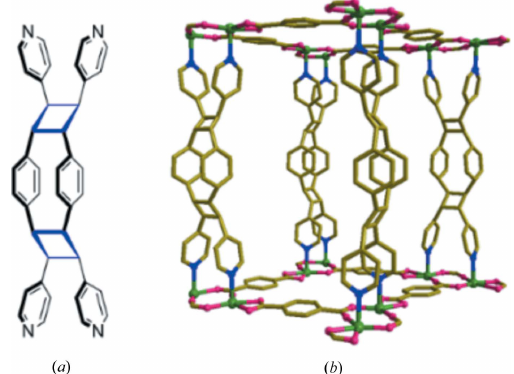
Figure 4 ( a ) Structure of the double-dimerized photoproduct of bpeb pairs, namely, tppcp. ( b ) A portion of the structure of ( 4 ) showing the double- dimerized photoproduct of trans , cis , trans -bpeb pairs. For clarity, the disorder and hydrogen atoms are not